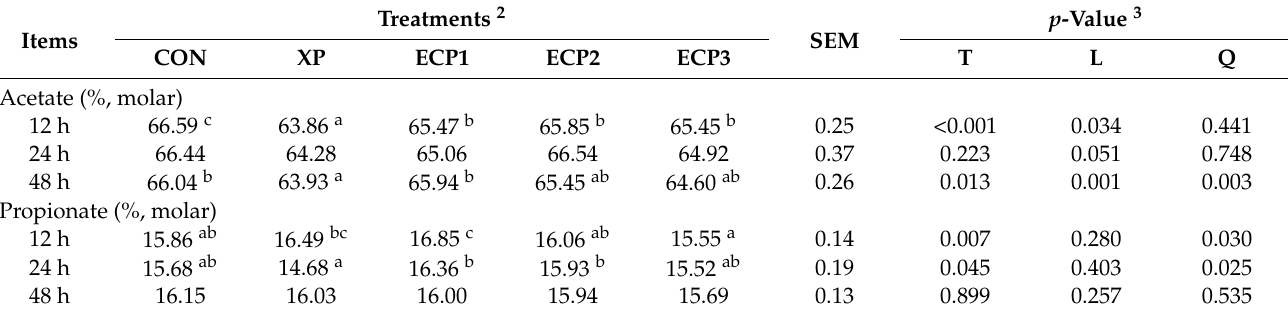
Table 4. Composition and production of VFAs under different levels of ECP supplementation 1